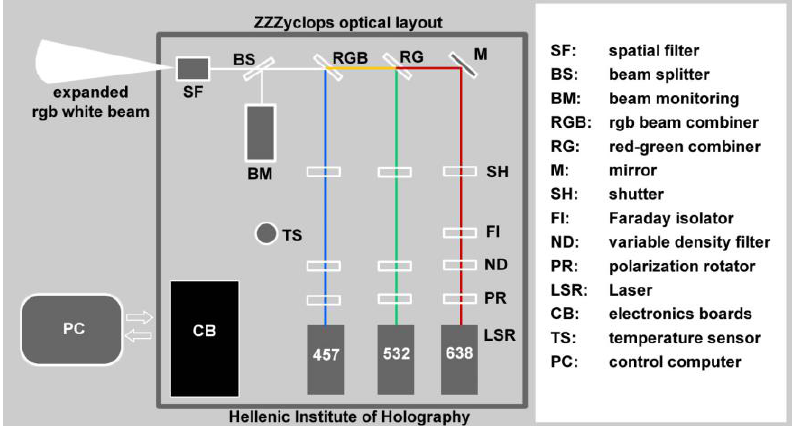
Figure 2. Inner layout of the ZZZyclops color holography camera.